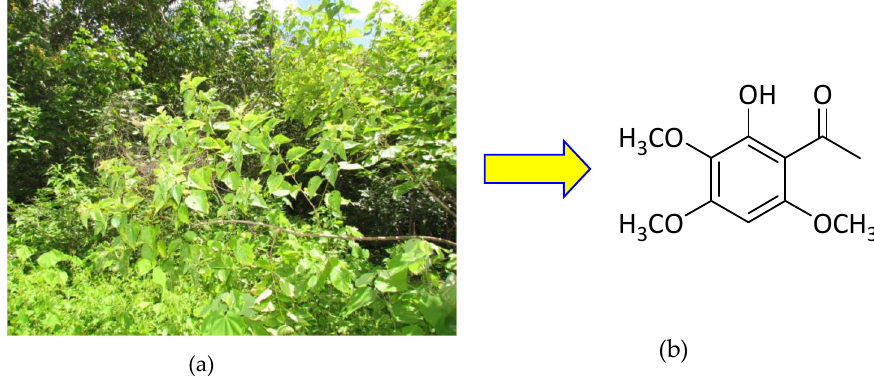
Figure 1. Aerial parts of C. Anisodontus ( a ) 2-hydroxy-3,4,6-trimethoxyacetophenone ( b ).